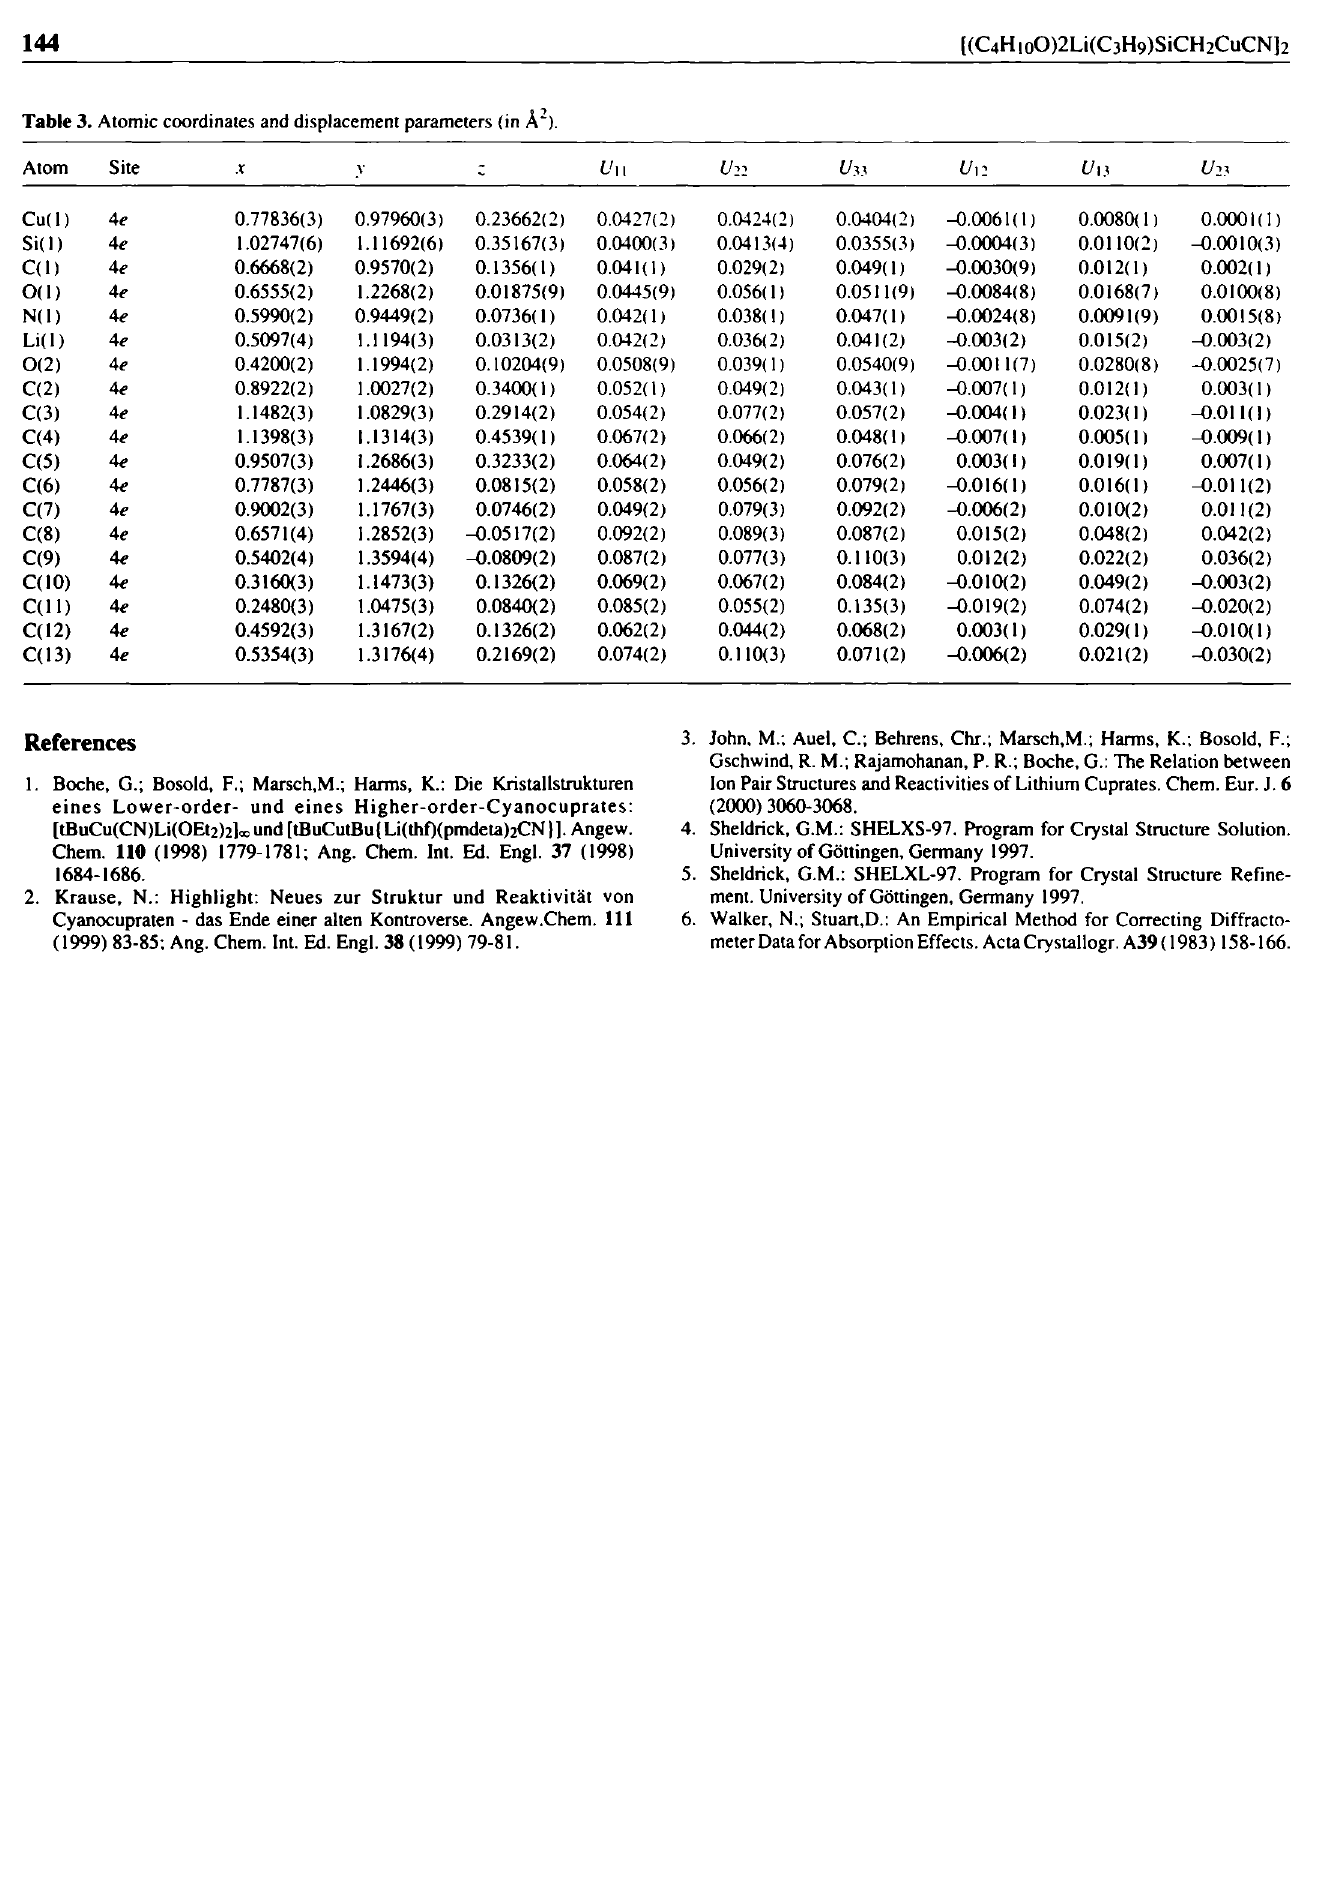
Table 3. Atomic coordinates and displacement parameters (in Ä 2